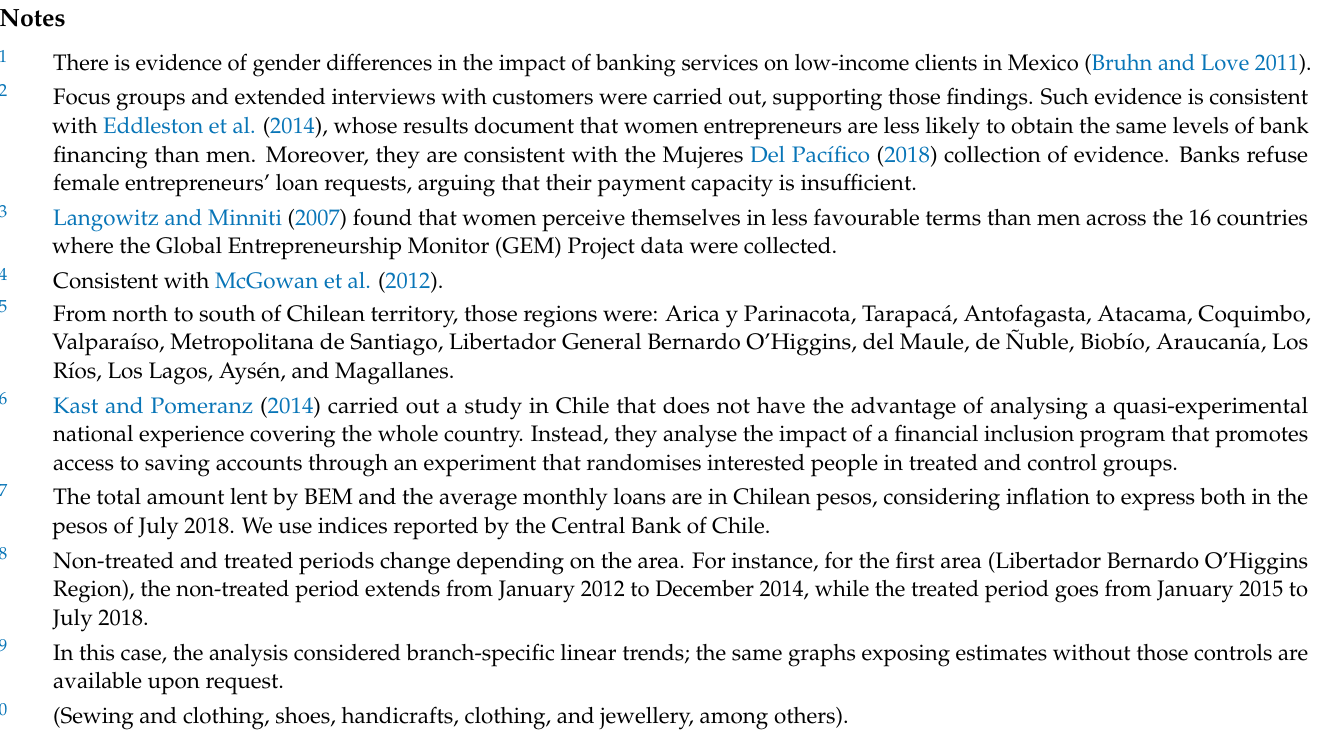
Figure 10. Parallel Trends Analysis—Event Studies on Loans Granted—Transport Sector.